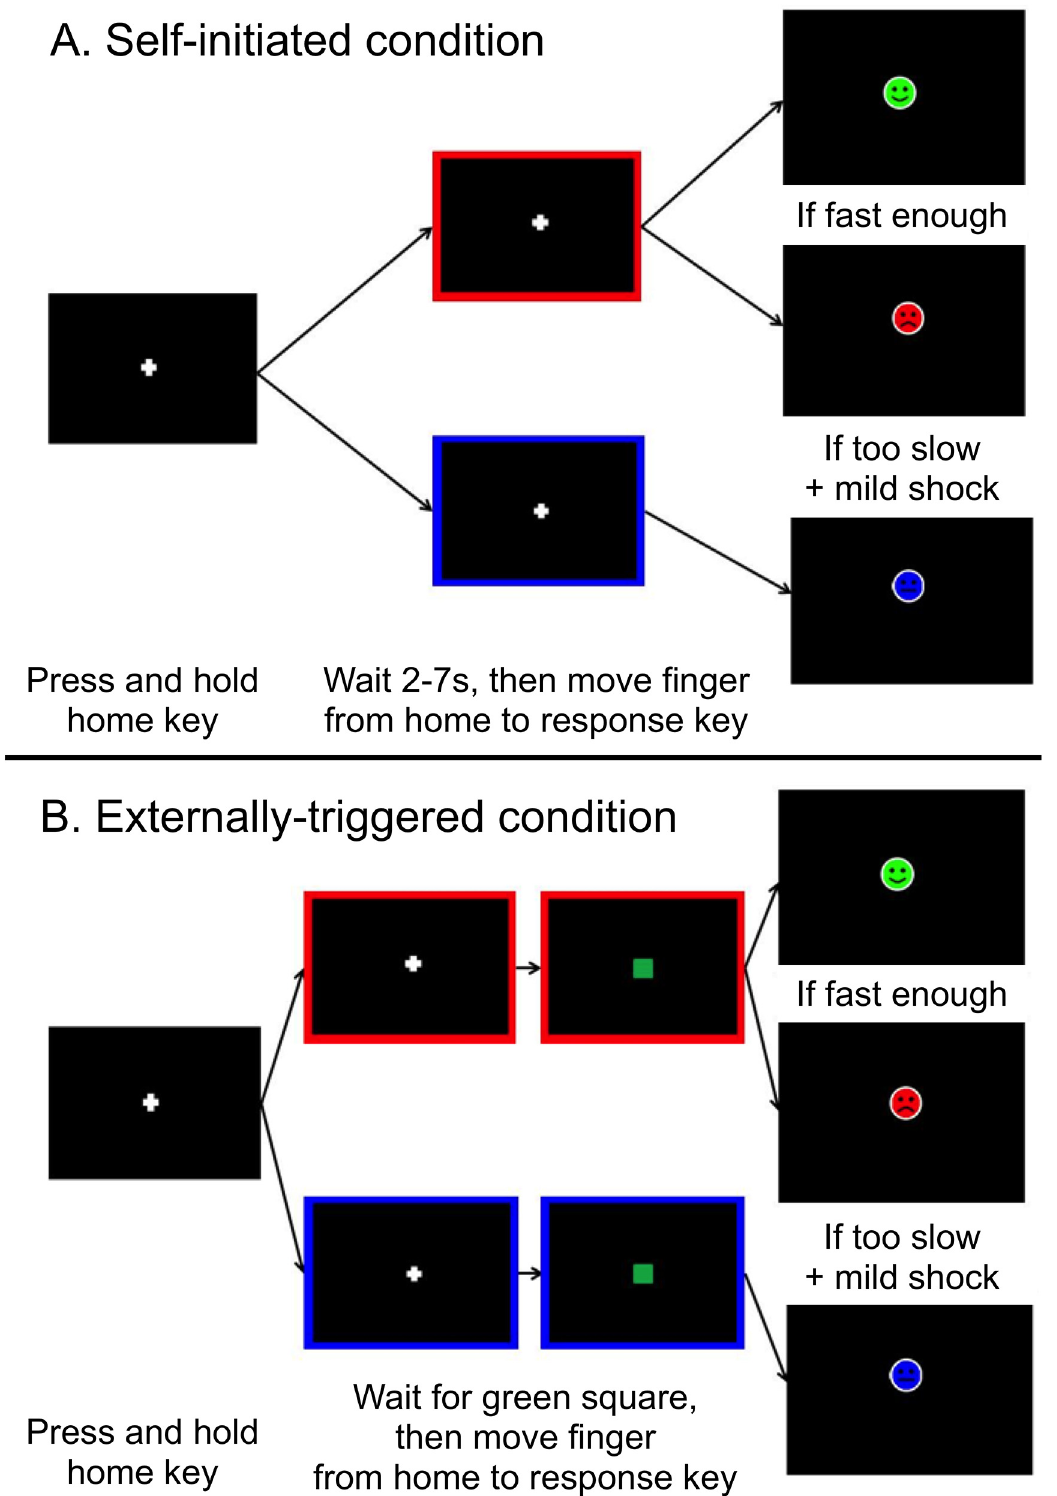
Fig 1. The Shock Avoidance Behavioural paradigm with self-initiated (A) and externally-triggered (B) conditions.